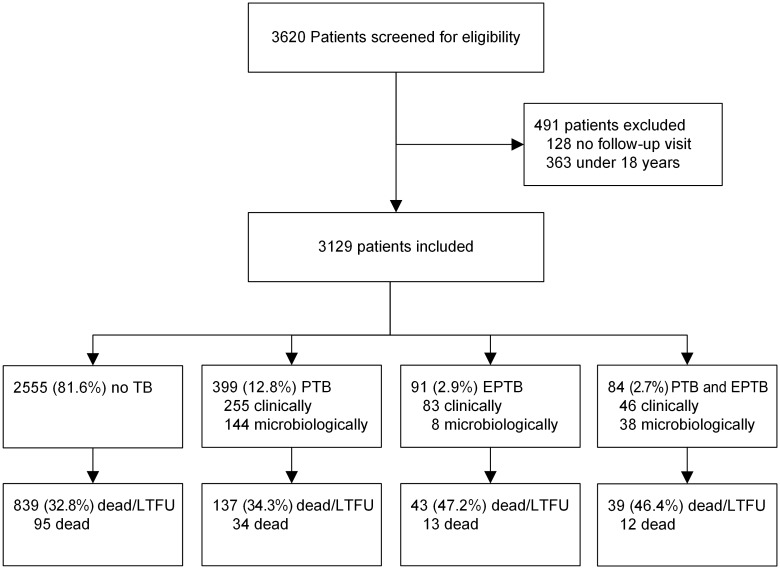
Flowchart of patients included in the study.Patients screened and included in the study. After inclusion, patients were allocated to 4 groups: patients with no tuberculosis (no TB), patients with pulmonary Tuberculosis (PTB), patients with extrapulmonary tuberculosis (EPTB) and patients with pulmonary and extrapulmonary tuberculosis. LTFU, lost to follow-up.